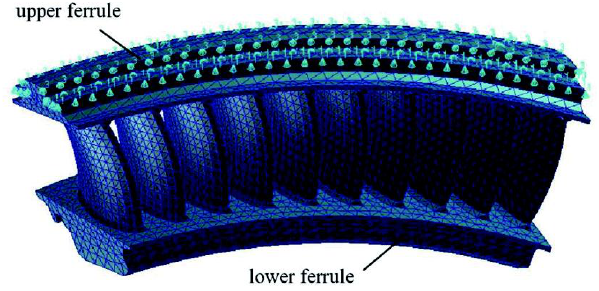
Fig. 1. Numerical model of the studied stator vane sector.